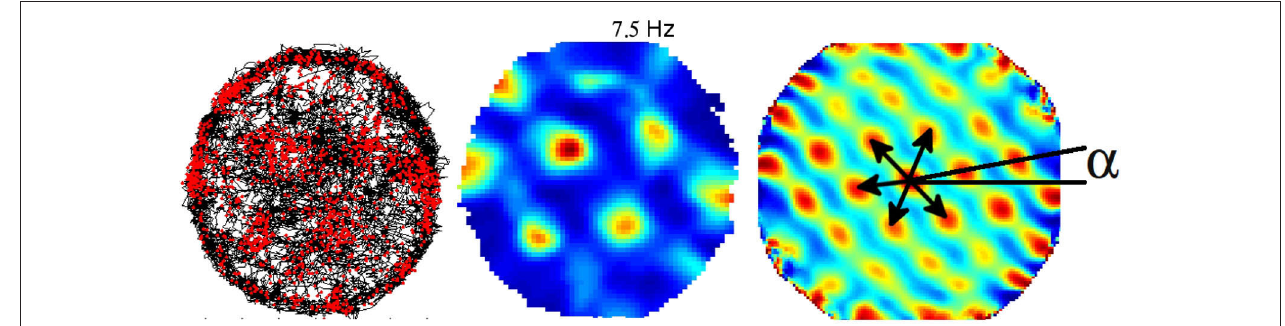
scale is from blue ( r = − 1) through green ( r = 0) to red ( r = 1). Black arrows represent the distances between peaks (the scale of the map), and a represents the angle between the horizontal line and the first firing field array (the orientation of the map). The phase of the map is represented by the position of the firing